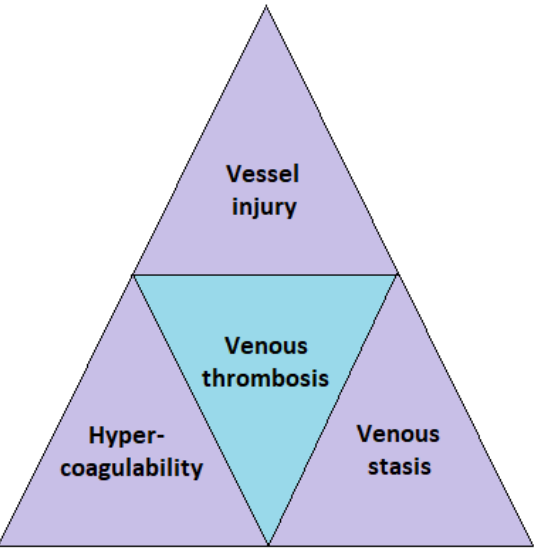
Figure 1. Virchow’s